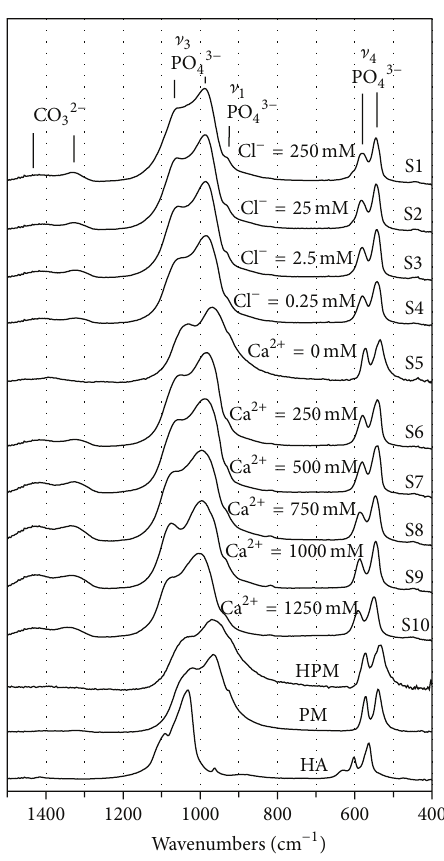
Figure 7: Synthetic apatites. FTIR spectra of the synthetic calcium lead apatites S1–S10 together with spectra for hydroxylpyromorphite (HPM), pyromorphite (PM), and hydroxylapatite (HA).